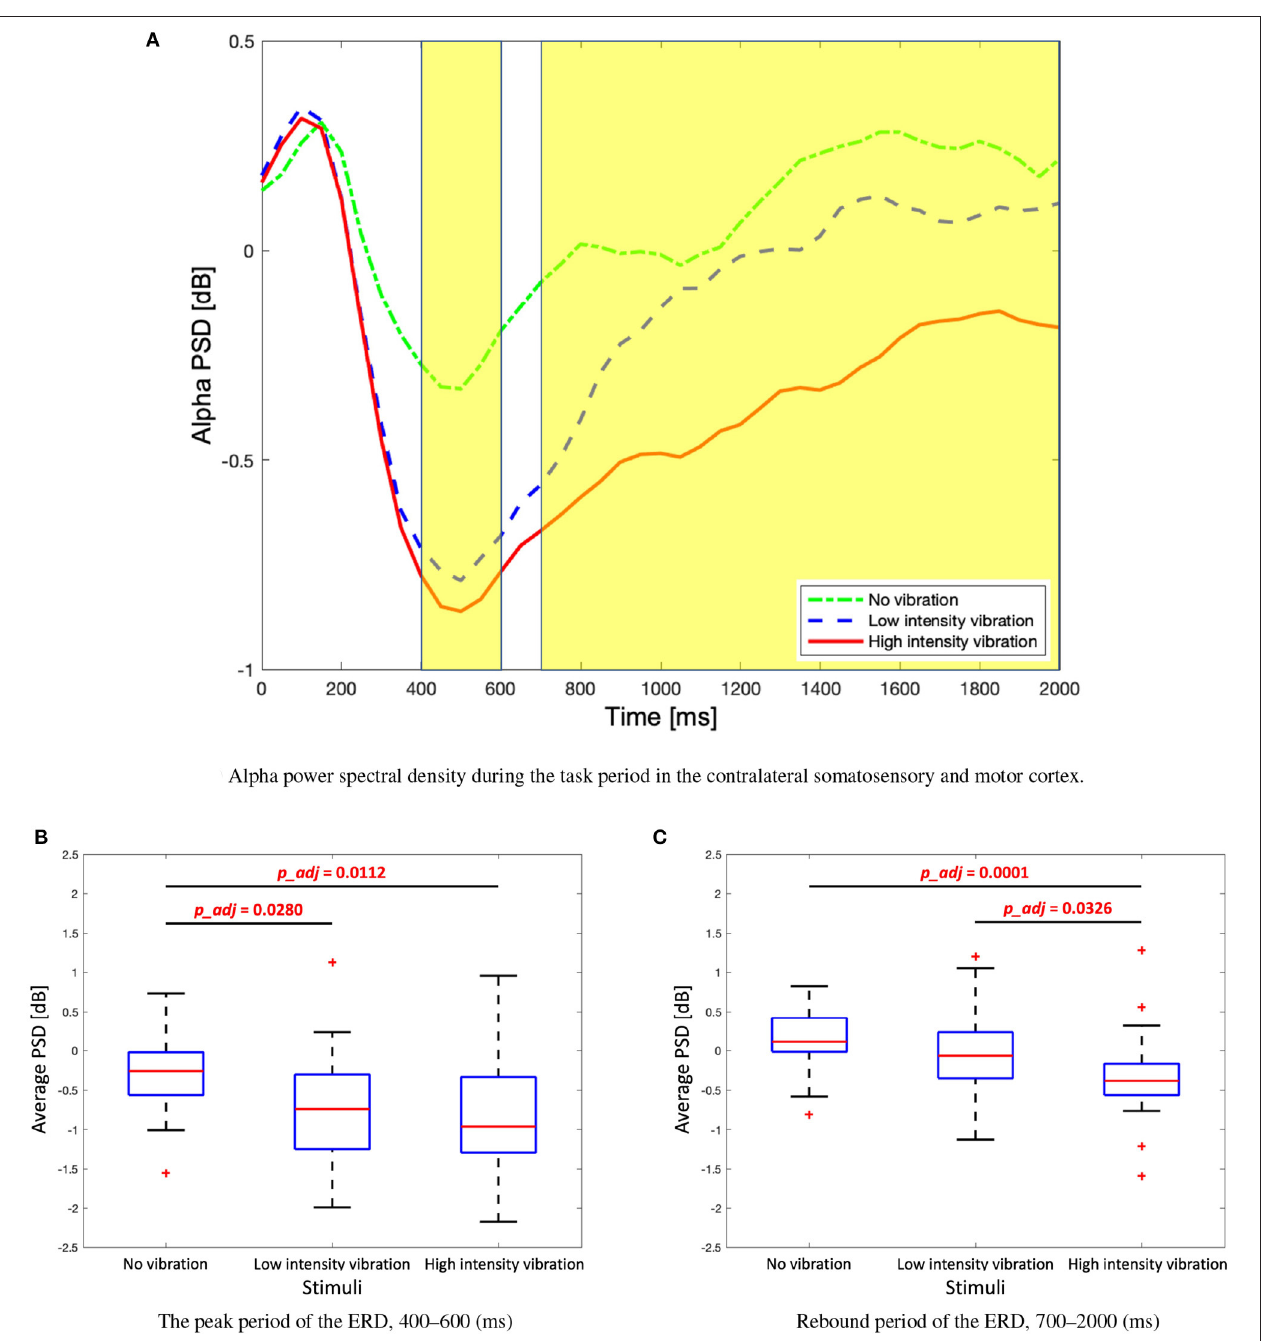
FIGURE 5 | (A) Time course alpha power spectral density during the task period in the contralateral somatosensory and motor cortex (C4, Cp2, and Cp6). Two highlighted periods indicate significant differences among three stimuli. (B) Box plots to show average alpha power spectral density of the first highlighted region, the peak period of the event-related desynchronization (ERD). One-way analysis of variance (ANOVA), F (2,86) = 5.76, Holm–Bonferroni correction. (C) Box plots to show average alpha power spectral density of the second highlighted regions, rebound period of the ERD. Kruskal–Wallis test, H (2) = 19.02, Holm–Bonferroni